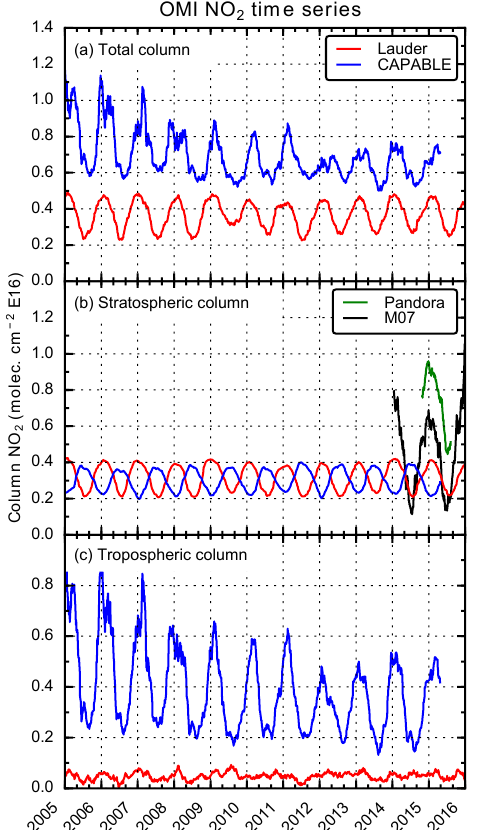
Figure 2. Time series plots for total- (a) , stratospheric- (b) , and tropospheric-column (c) NO 2 data products from OMI (L3, v3.0, vertical-column density) over Lauder (red) and CAPABLE (blue). OMI data were filtered to remove cloud fractions greater than 20% and overpasses greater than 50km from the site. A 7-day normally weighted rolling mean was applied to smooth the plots and remove higher-frequency fluctuations. Pandora (green) and M07 (black) data presented in panel (b) are slant-column densities.